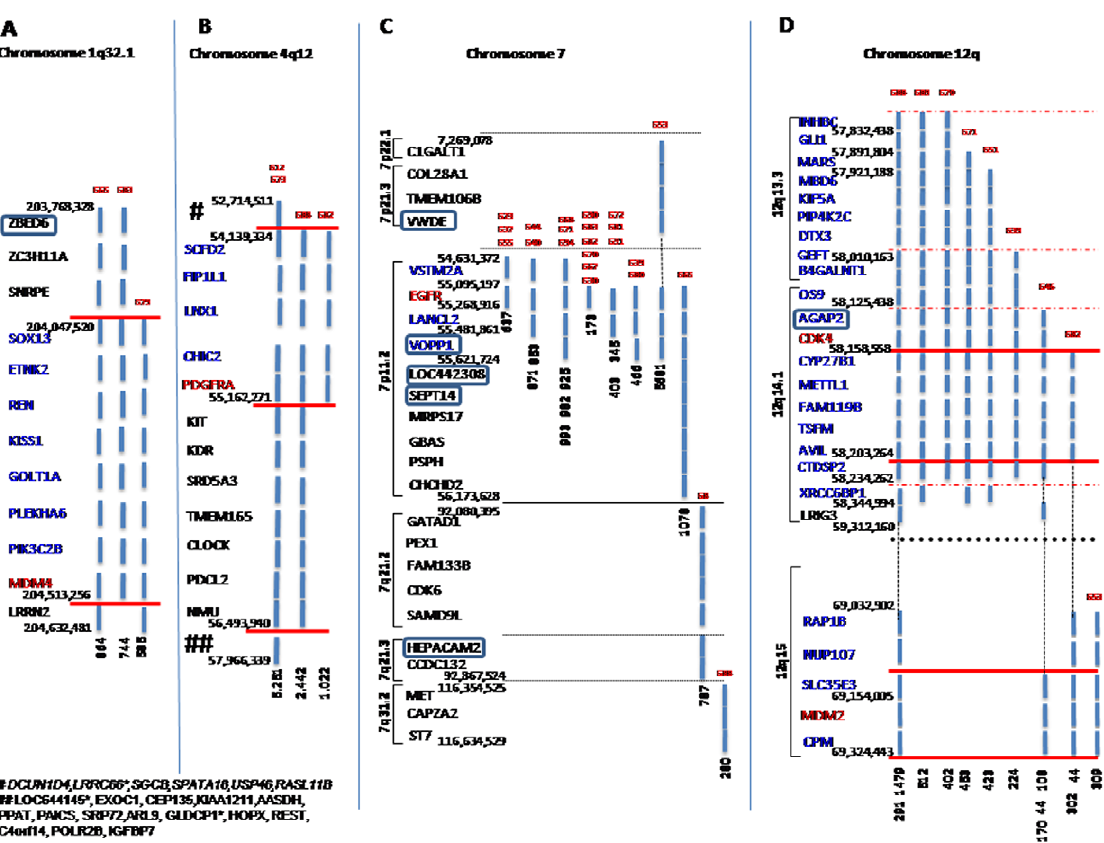
Figure 1. Frequently amplified chromosomal regions in GBM. Detailed characterization of the extension and the gene coded in those segments of chromosomes 1 (A), 4 (B), 7 (C) and 12 (D) found to be recurrently amplified in GBM by SNP-arrays. The identification code for each tumor isplaced on top of each line (G–N.), the length size of the amplicon in Kb is placed at the bottom of the amplified regions, and both the starting and ending positions of the amplicons are shown at the left of each chromosomal region. All genes affected in common for each amplified chromosomal segment are displayed; previously reported candidate genes amplified in a significant number of cases are shown in red, other frequently amplified genes are depicted in blue, whereas genes depicted in black correspond to genes amplified at low frequencies. A total of 6 amplified genes ( DCUN1D4, LRRC66*, SGCB, SPATA18, USP46, RASL11B ) and fifteen amplicons ( LOC644145*, EXOC1, CEP135, KIAA1211, AASDH, PPAT, PAICS, SRP72, ARL9, GLDCP1*, HOPX, REST, C4orf14, POLR2B, IGFBP7 ) were additionally found in cases G12 and G73, respectively. Genes without expression values in the GEP-array are highlighted with square boxes in the figure and with an asterisk in this legend.